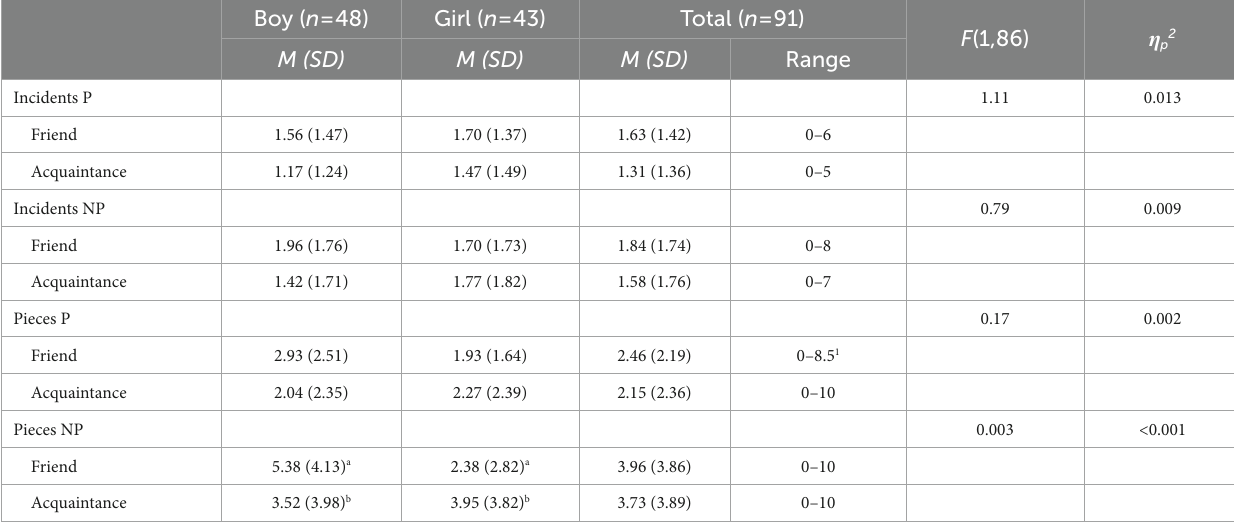
TABLE 2 Means and standard deviations for sharing incidents and number of pieces of preferred and non-preferred food shared with friends and acquaintances, separately for boys and girls.